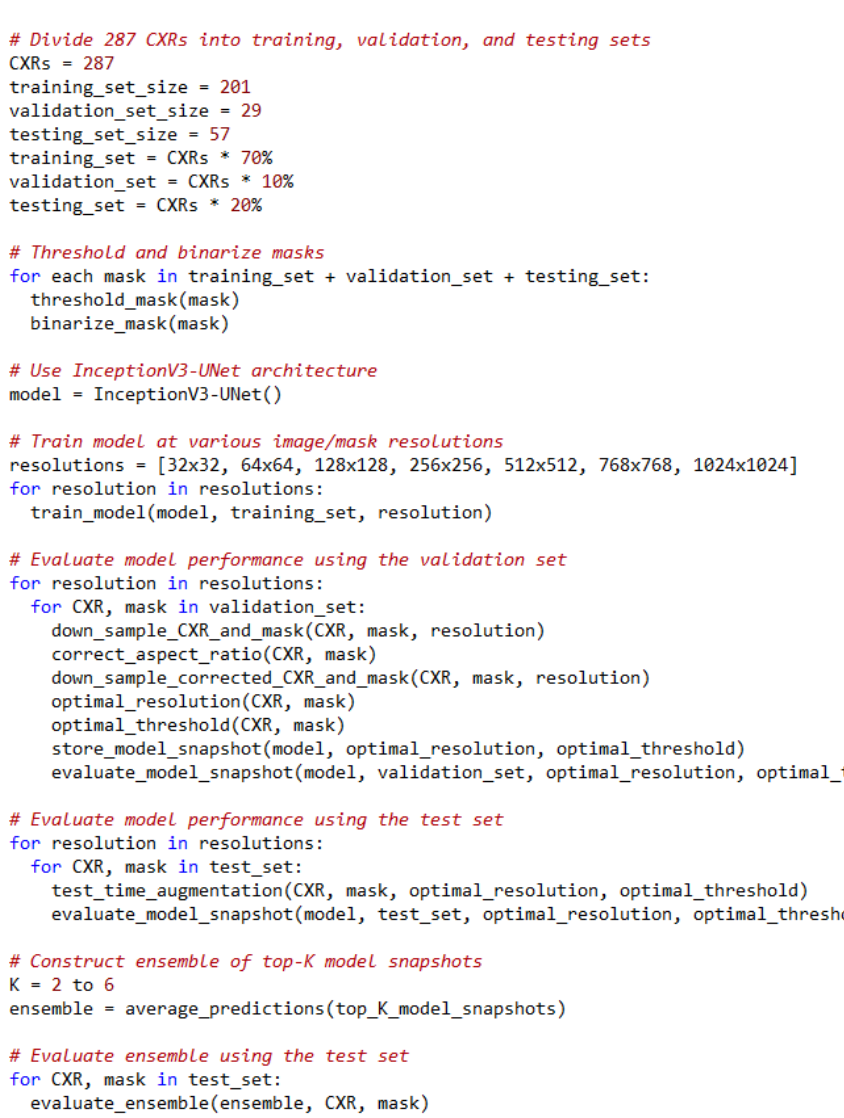
Figure 3. A combinatorial workflow showing the storage of model snapshots and identifying the optimal TTA combination at the optimal segmentation threshold for each snapshot. The term “Original pred.” refers to the model predicting the original, non-augmented data.